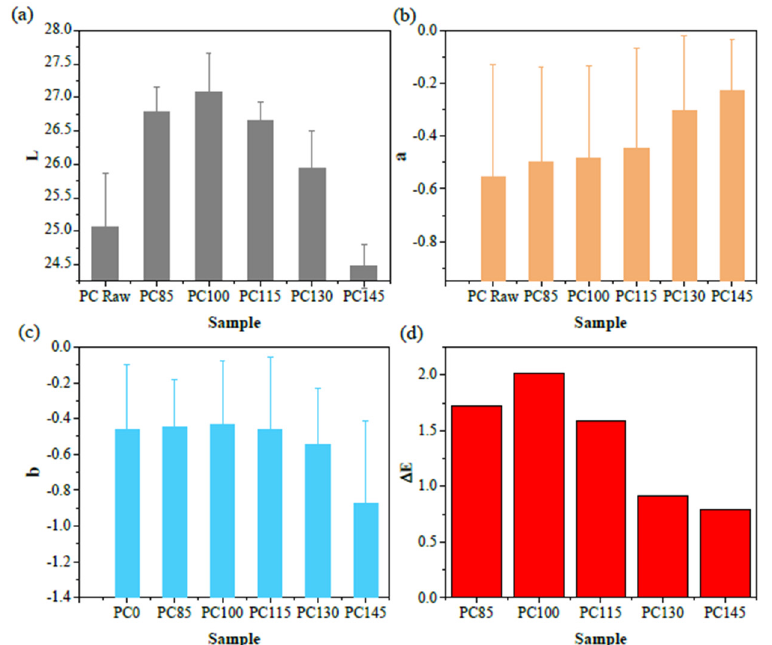
Figure 2. The CIELAB values and Δ E of the GF-PC composites before and after aging. ( a ) “L” of the composites; ( b ) “a” of the composites; ( c ) “b” of the composites; ( d ) “ Δ E” of the composites after